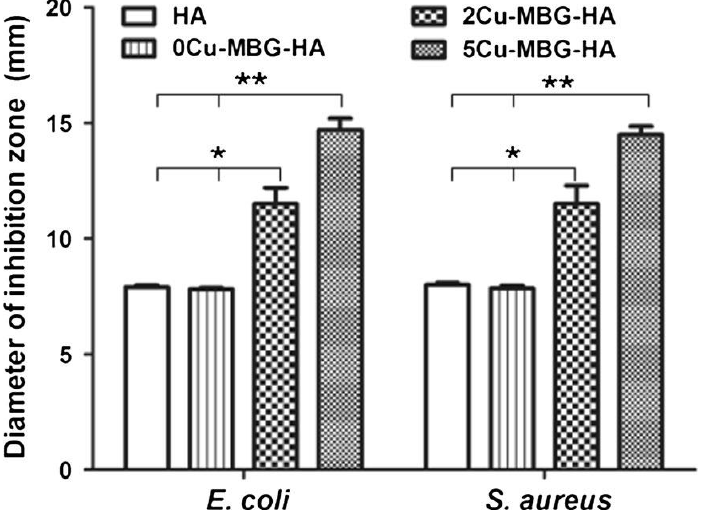
Figure 2. Diameter of the inhibition zones of Escherichia coli and Staphylococcus aureus growth formed in vitro around the wells (7.8 mm diameter of Oxford cup) filled with hydroxyapatite orbital implants coated or not with the copper-doped mesoporous bioactive glass (MBG) layer (* p < 0.05; ** p < 0.01). Reproduced from Reference [57] .